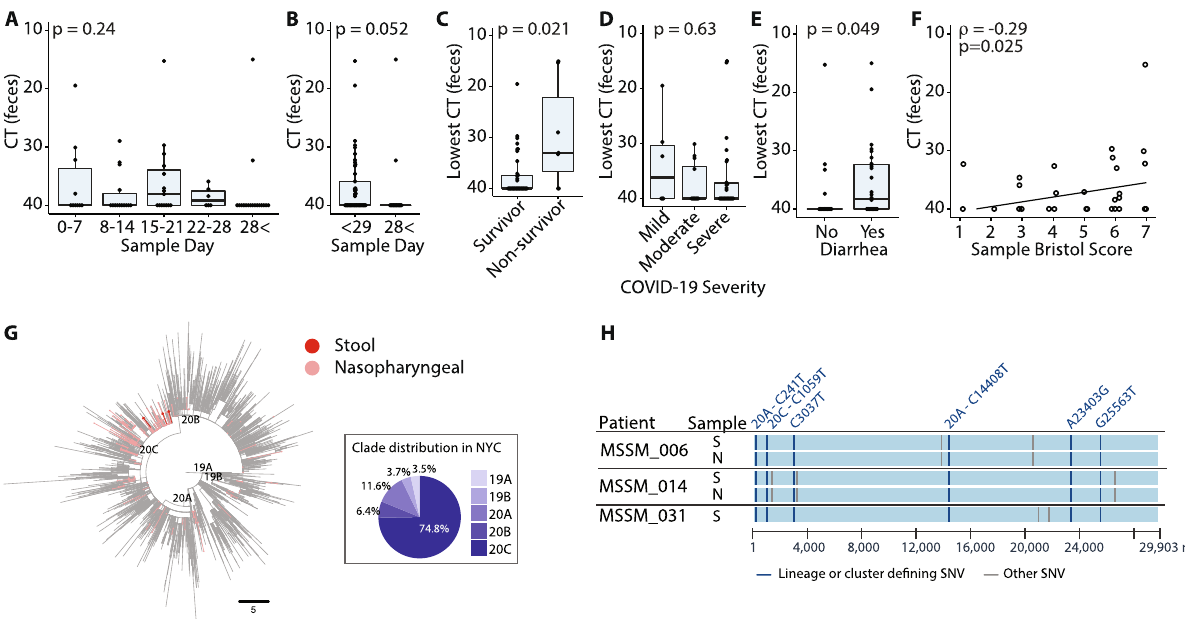
Figure 2. Detection and sequencing of SARS-CoV-2 virus genome in stool. ( A ) The median fecal SARS-CoV-2 Ct of each sample, plotted according to the time of collection relative to either the onset of symptoms or the first positive nasal PCR. p value—Kruskal–Wallis. ( B ) The median fecal SARS-CoV-2 Ct of each sample, plotted according to the relative time of collection: day 28 as a cut off. Relative to either the onset of symptoms or the first positive nasal PCR. p value—Mann–Whitney. ( C ) The lowest fecal SARS-CoV-2 Ct measured for each donor shows higher peak viral loads in donors who did not survive. p value—Mann–Whitney. ( D ) The lowest fecal SARS-CoV-2 Ct value measured from each donor during admission, plotted according to the peak severity of COVID19 symptoms— p value—Kruskal–Wallis. ( E ) Fecal SARS-CoV-2 Ct values in samples from donors with and without diarrhea. p value—Mann–Whitney. ( F ) The relationship between the fecal SARS-CoV-2 Ct values and the Bristol Score of each sample. Spearman rank test. ( G ) Phylogenetic relationships of the SARS- CoV-2 isolates from stool (Stool, dark red) and other nasopharyngeal virus isolates from the Mount Sinai Health System (MSHS) in NYC (Nasopharyngeal, salmon), in a background of global strains (grey). Main phylogenetic clades are indicated. The scale bar represents divergence from the root (reference genome NC_045512) as number of single nucleotide variants (SNVs). The panel in the bottom right indicates the clade distribution of the MSHS nasopharyngeal samples from 403 SARS-CoV-2 genomes from February 29 to July 15. ( H ) Sequence alignment depicting clade and cluster defining (teal), and other (grey) SNVs present in the stool SARS-CoV-2 isolates from stool (S) or nasopharynx (N) of the indicated donors. The clade and amino acid substitutions are indicated when